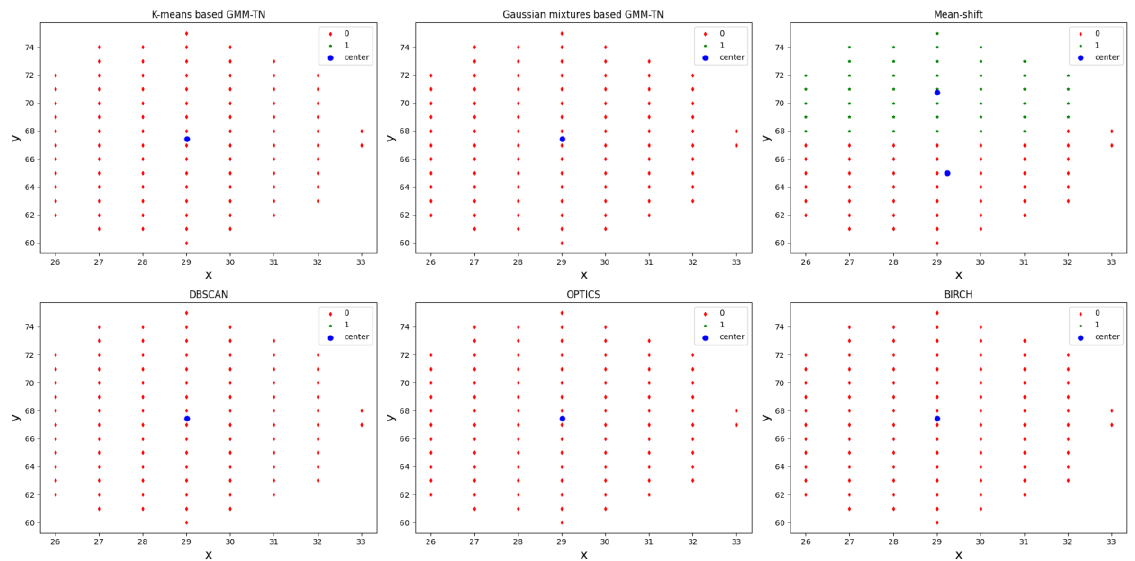
Figure 16. Automatic target number estimation results (single target) using K-means-based GMM-TN, Gaussian-mixtures-based GMM-TN, Mean-shift, DBSCAN, OPTICS, and BIRCH.